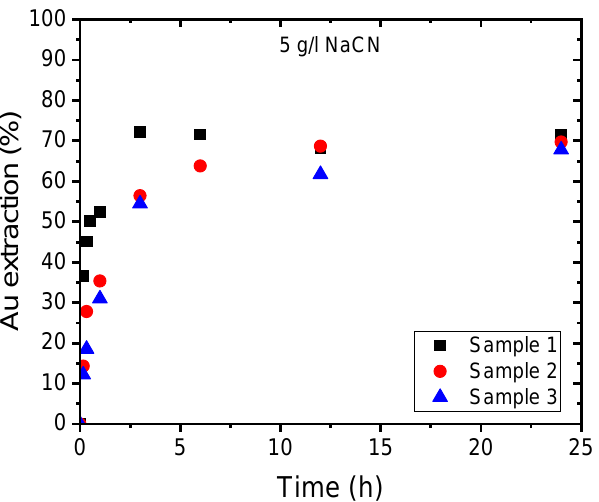
Figure 8. Au extraction at 3 g/L NaCN (30% solids, −300 + 150 µm PSD, 300 rpm, 26 °C).